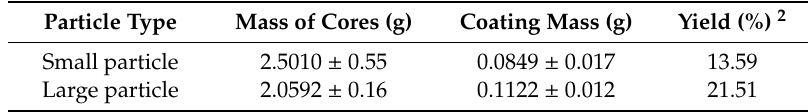
Table 3. Yield of aerosol coating process with different particles 1 .